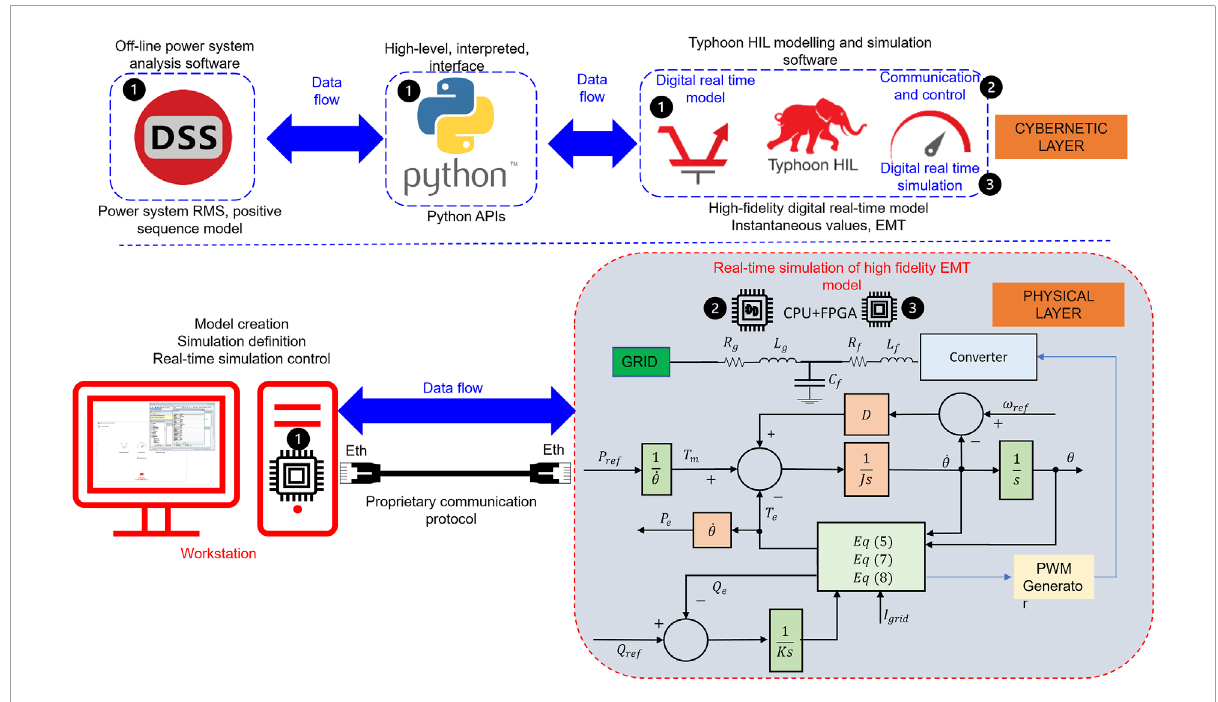
FIGURE 4 Overall methodology of proposed real-time Volt-Var control using cyber-physical co-simulation framework.